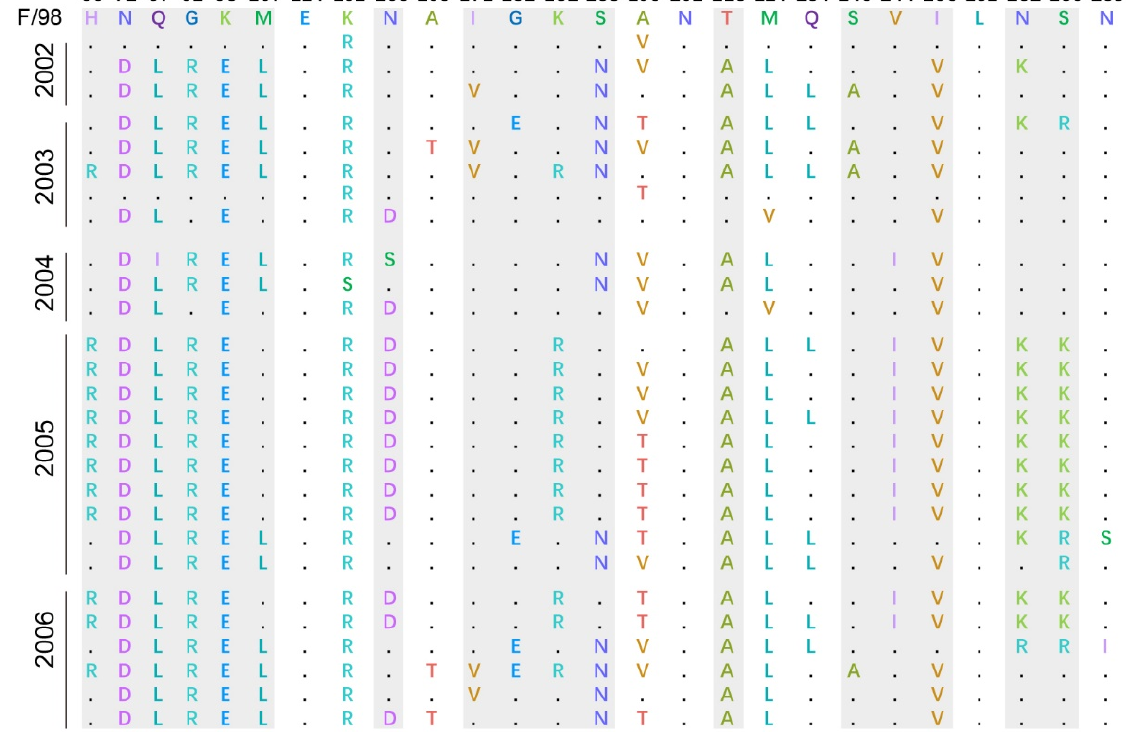
Figure 5. Distribution of mutational sites of the H9N2 subtype AIV at different time periods. ( A ) Sequence alignment of HA protein and F/98 protein of H9N2 subtype AIVs from 2002 to 2006. ( B ) Sequence alignment of HA protein and F/98 protein of H9N2 subtype AIVs from 2009 to 2013. The numbers in the first row indicate the location of the protein sites; the mutation sites reported are marked with a white background; the positive sites found in this study are shown with a light gray shade; and the strain name is on the left. The horizontal lines represent insertional mutations.